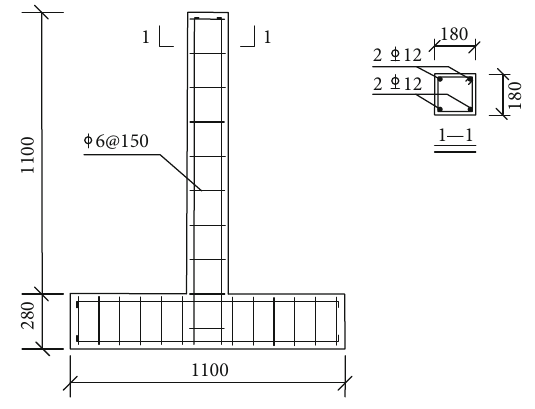
Figure 1: Design size of column